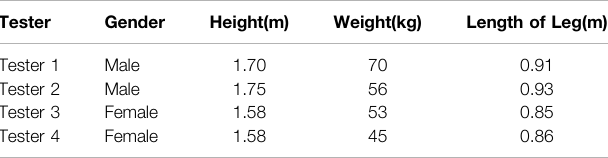
TABLE 3 | Physical characteristic values of